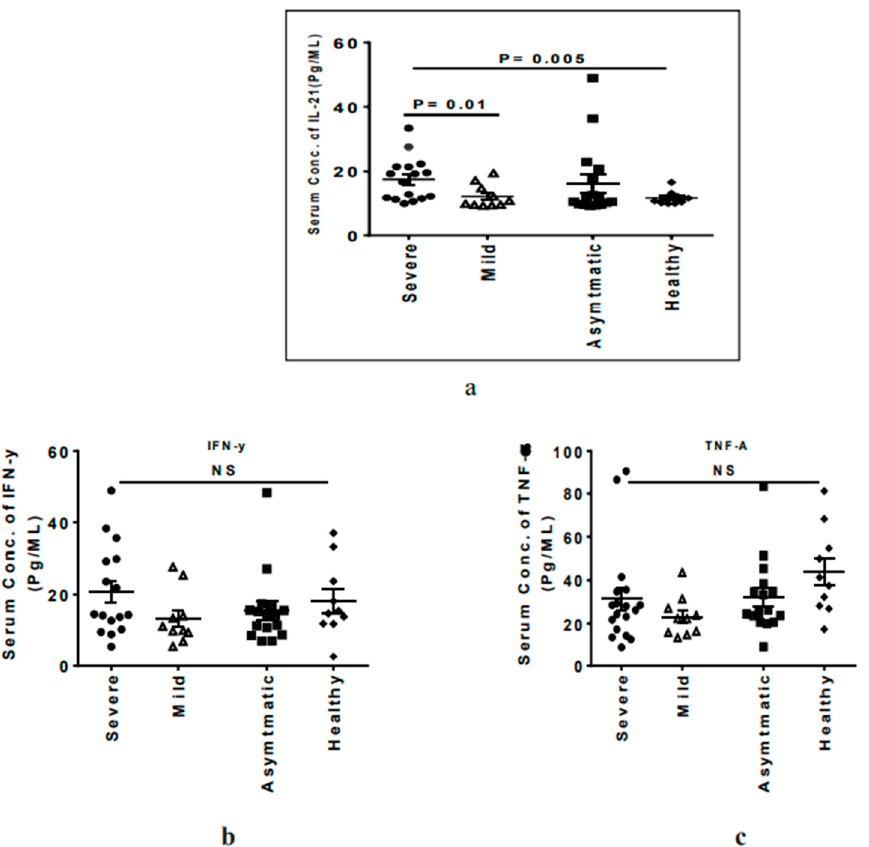
Figure 5. Dot plot graph showing the levels of different cytokines in the study groups: horizontal short bars indicate the mean ± standard deviation. p < 0.05 is considered significant. ( a ) IL-21, ( b ) IFN- γ , ( c ), TNF- α .